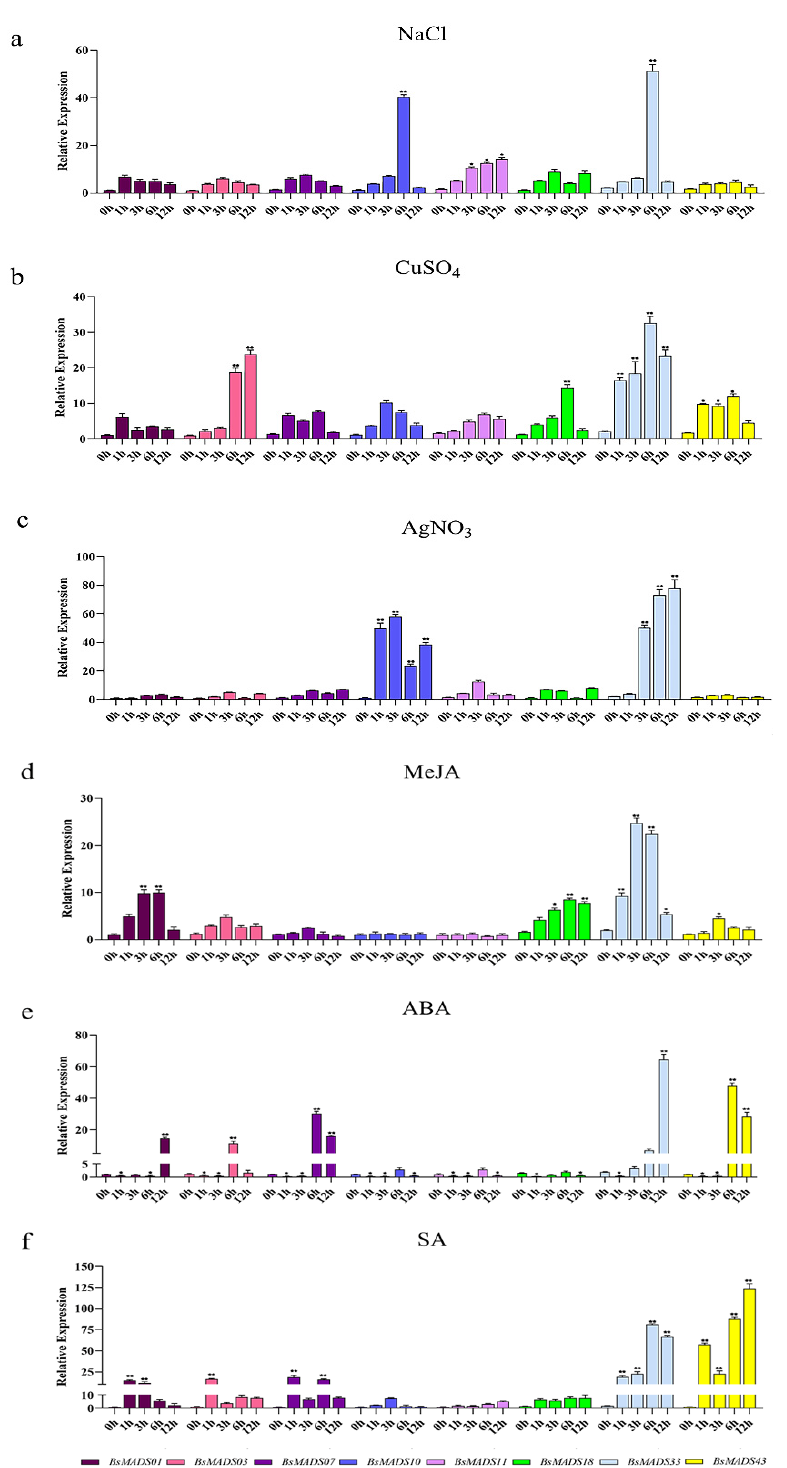
Figure 8. The expression levels of 8 BsMADSs in response to various stress treatments at 0, 1, 3, 6, and 12 h: ( a ) NaCl, ( b ) CuSO 4 , ( c ) AgNO 3 , ( d ) MeJA, ( e ) ABA, and ( f ) SA. The data were analyzed via the two-way method using GraphPad Prism, version 8. Asterisks ( p < 0.05) indicate significant differences compared with the control group (* p < 0.05, ** p < 0.01). Error bars represent standard error for data obtained in three biological replicates.